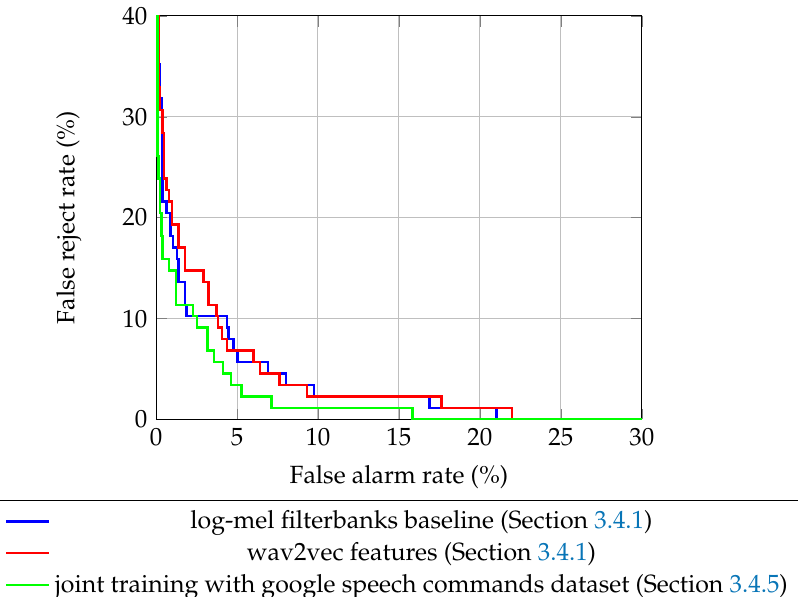
Figure 5. The quality of repeat detection on operation points with false alarm rate less than